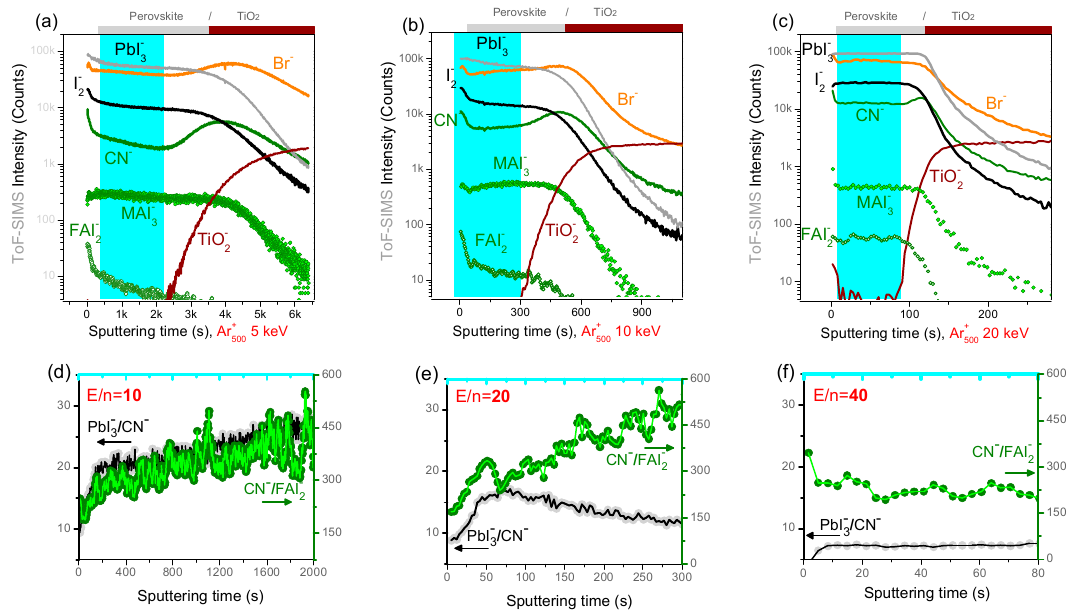
Figure 5. ToF ‐ SIMS depth profiles acquired on Perovskite/cTiO 2 model samples with constant argon cluster size ( n = 500) and variable energy. Constant profiles indicate the non ‐ accumulation of damages during the profile. ( a,d ): E = 5 keV ( E/n = 10 eV); ( b,e ): E = 10 keV ( E/n = 20 eV); ( c,f ): E = 20 keV ( E/n = 40 eV). Bottom panels show that ( i ) a higher preferential sputtering of organic molecules occurs at low cluster energy (PbI 3 ‐ /CN ‐ ratios) and ( ii ) a lower fragmentation of organic molecules occurs with 20 keV Ar 500+ beam (CN ‐ /FAI 2 ‐ ).